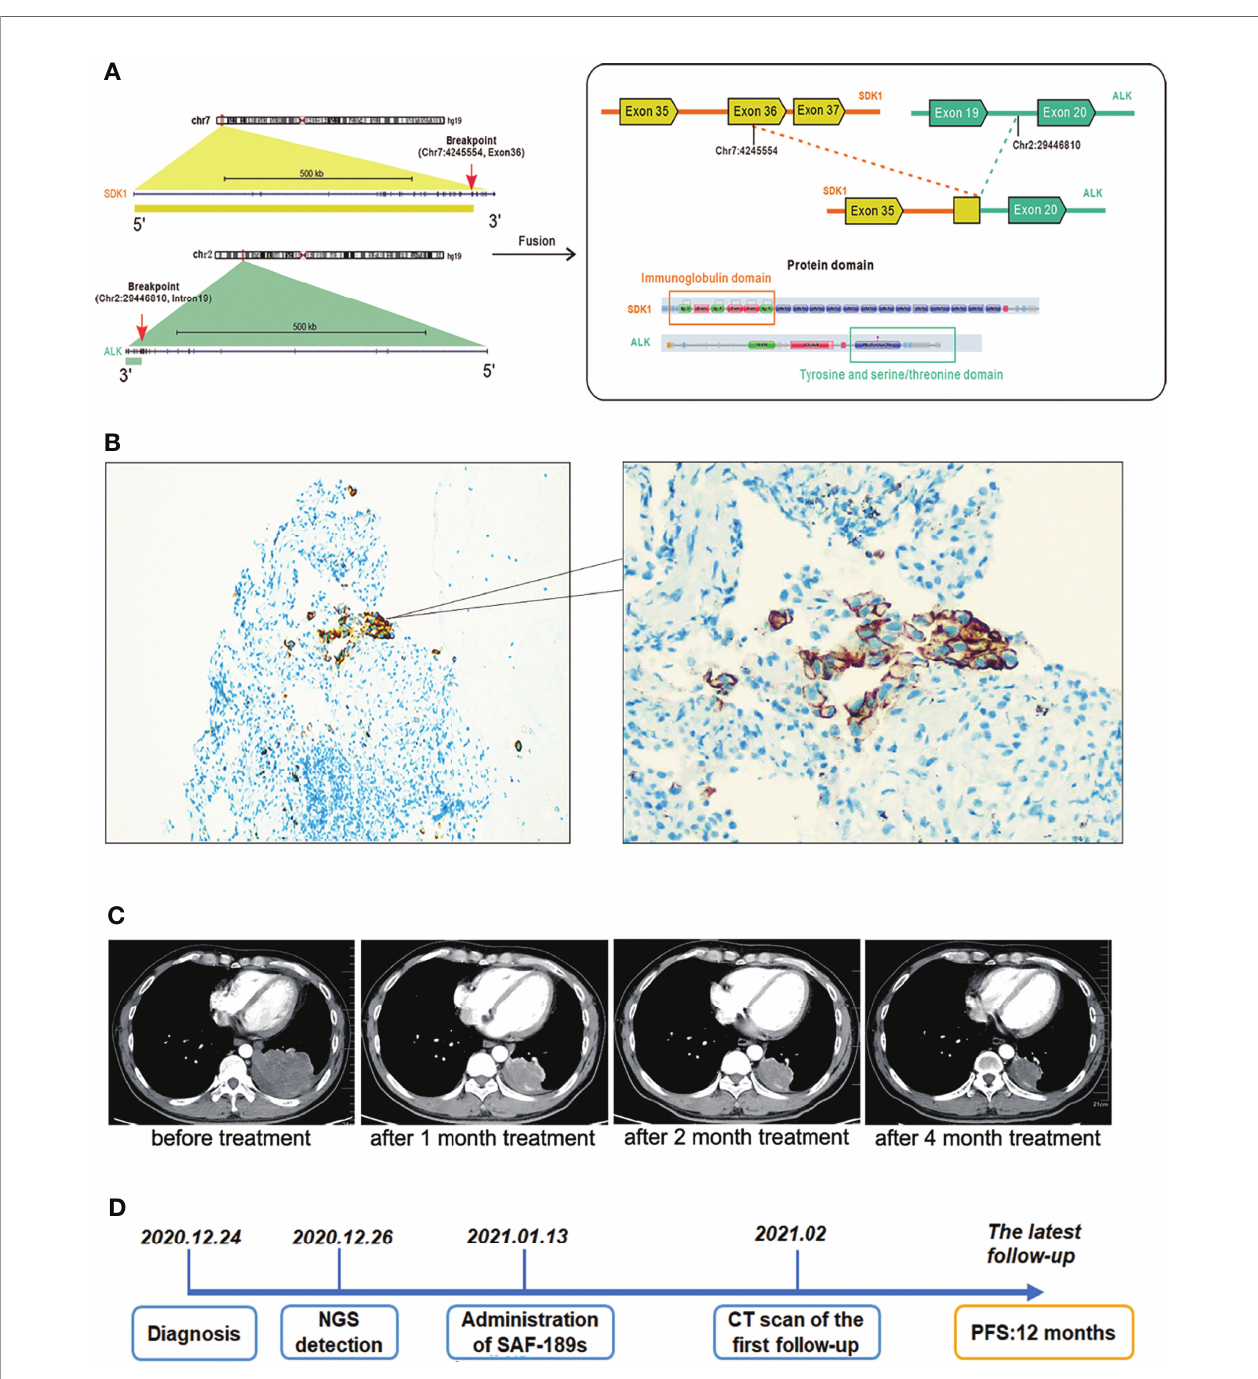
FIGURE 1 | A Chinese patient with adenocarcinoma harboring a novel SDK1-ALK fusion variant exhibited excellent response to ALK inhibition. (A) The schematic diagram. (B) IHC showed the positive expression of ALK protein. Cancer cells showed an uneven stippled cytoplasmic and perimembranous staining pattern. (C) Compared with the baseline images, the size of the lesion in the left lower lobe, as well as lymph nodes in left hilum and mediastinum was signi fi cantly reduced after this patient was treated with SAF-189s for 1 month, 2 months, and 4 months. (D) The timeline diagram of this case. At the time of the latest follow-up, he tolerated well with only grade 1 rash and had a 12-month progression-free survival. Now he continues to be in partial response and keeps on SAF-189s